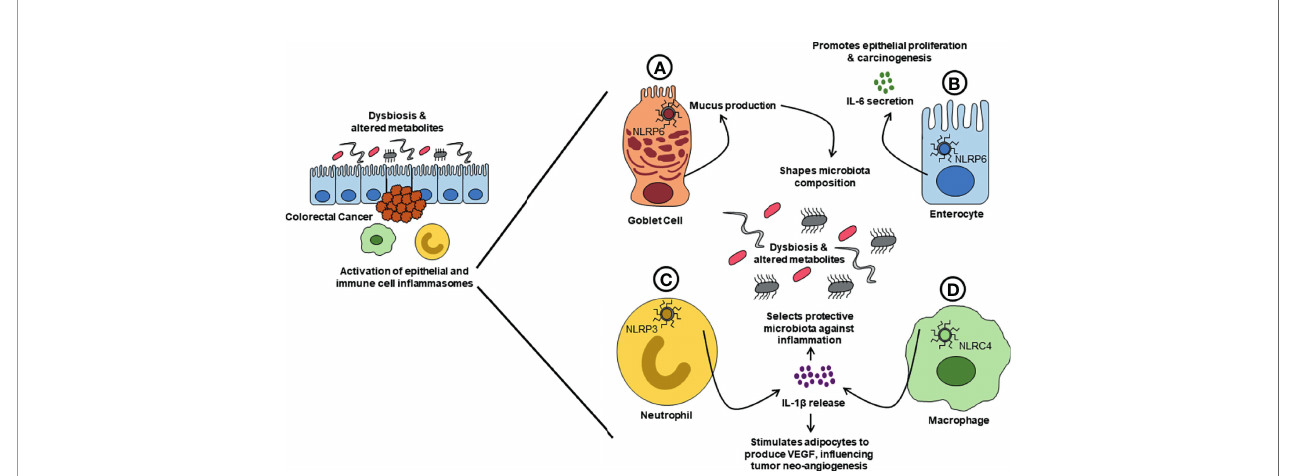
FIGURE 1 | Proposed mechanisms of action for the in fl ammasome – microbiome axis in CRC. Alterations in composition and functionality of the gut microbiome (dysbiosis) and subsequent changes in microbial-derived metabolites can trigger in fl ammasome activation in both immune cells and IECs. Activation of the in fl ammasome (s) causes increased release of in fl ammatory cytokines (e.g., IL-1 b and IL-18) and can lead to lytic cell death (pyroptosis). The effects of in fl ammasome activation can, in turn, contribute to shaping the biogeography and functions of the gut microbiome. (A) Upon activation of NLRP6 in fl ammasome, a speci fi c population of goblet cells (GCs) communicates with other responsive GCs through GAP junctions to increase their production of mucus, which can result in quantitative and qualitative alterations of intestinal mucus that can subsequently affect microbiome composition and in fl uence CRC development. (B) Activation of NLRP6 in fl ammasome in enterocytes induces increased production of IL-6, which stimulates IEC proliferation, and potentially promotes tumor development and growth. (C) Activation of NLRP3 in neutrophils induces increased secretion of IL-1 b , stimulating the production of antimicrobial peptides that shapes the gut microbiome towards an anti-in fl ammatory phenotype, thus protecting against CRC development. (D) In a model of diet-induced obesity, tumor-in fi ltrating macrophages increase the secretion of IL-1 b in response to activation of the NLRC4 in fl ammasome. IL-1 b then stimulates adipocytes to produce VEGF, which controls tumor neoangiogenesis and in fl uences its development. Collectively, changes in gut microbiome and activation of in fl ammasomes can either promote or suppress the development of CRC. CRC, colorectal cancer; IL, interleukin; NLRC, NLR family CARD domain containing; NLRP, NLR pyrin domain-containing protein; VEGF, vascular endothelial growth